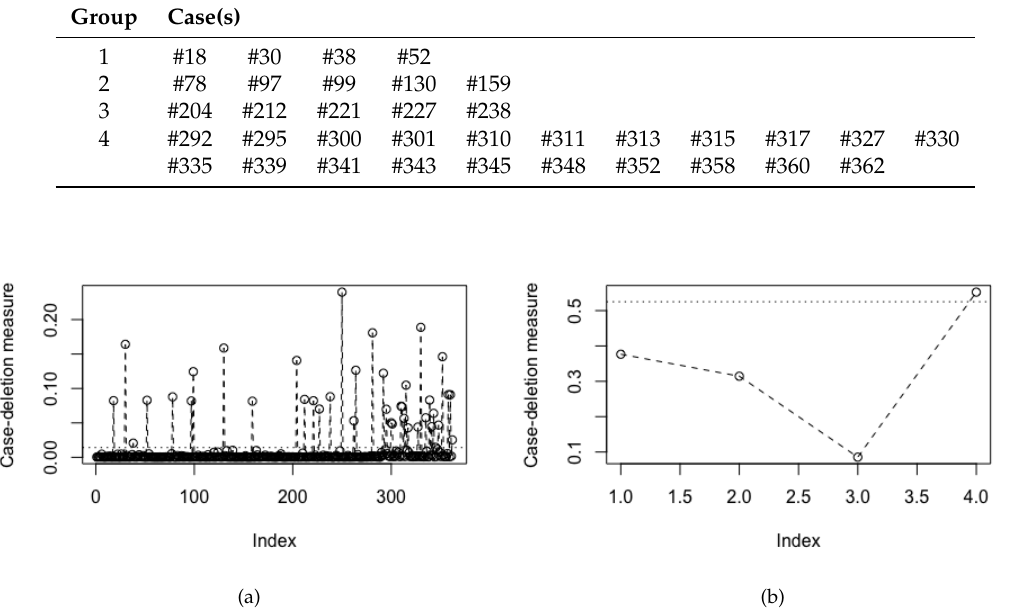
Figure 1. Index plots of global influence for asthma data: ( a ) cases and ( b )